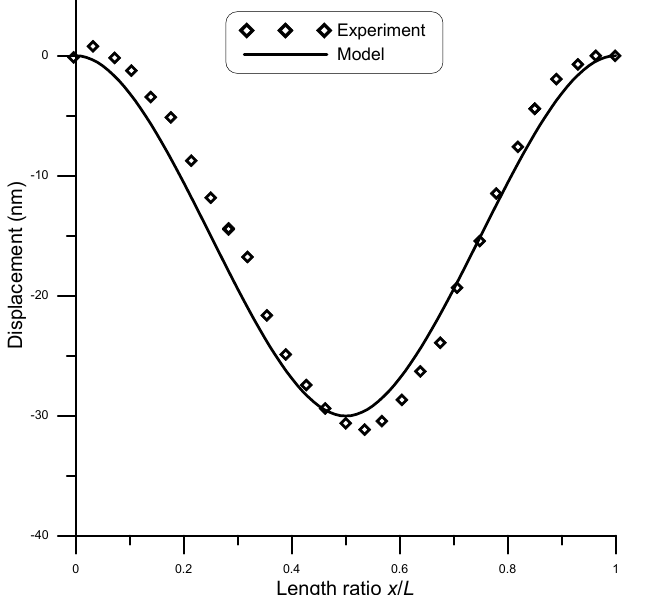
Figure 9. Displacement of a 1 µ m long beam of 65.9 nm diameter under point load of 62 nN, compared to experimental data [26].